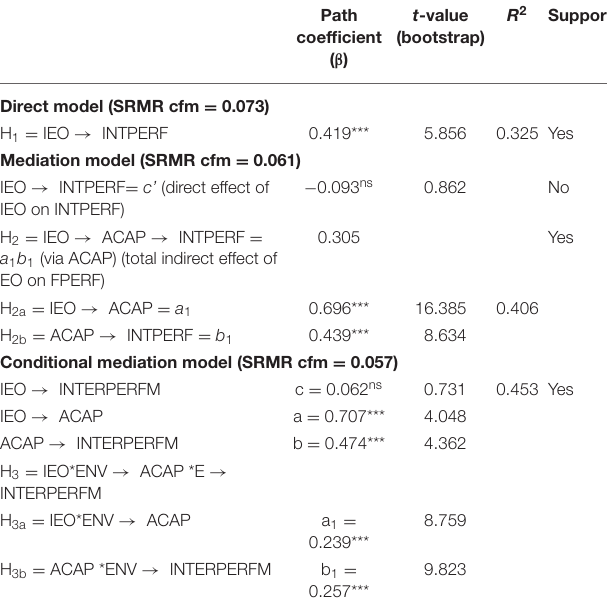
TABLE 11 | Structural model.